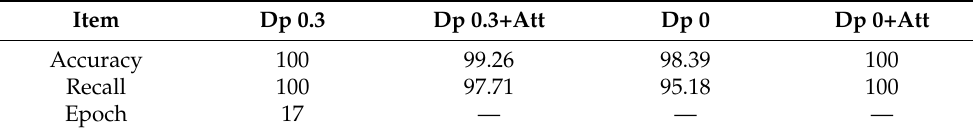
Table 2. Comparison of performance indicators of four network structures